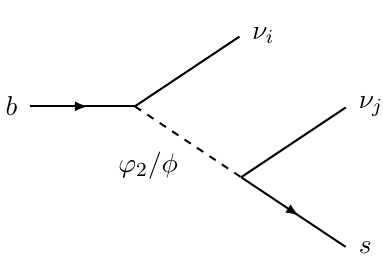
Figure 14. Dominant BSM contribution to b ! s(cid:23)(cid:23) process in this model arises at